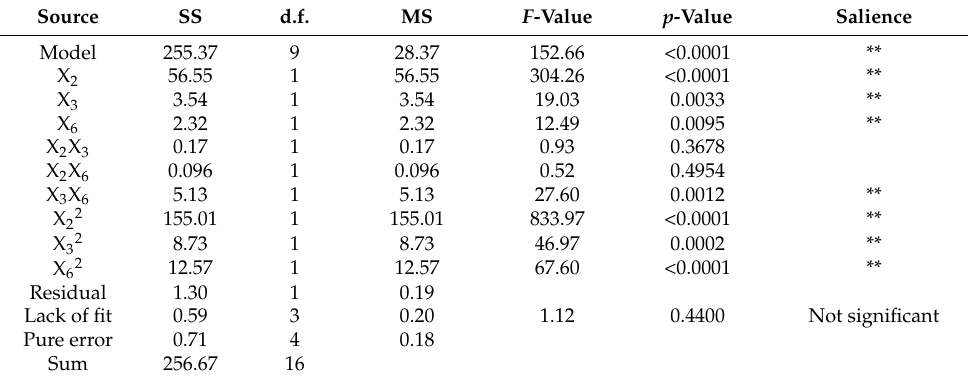
Table 6. Box–Behnken test variance